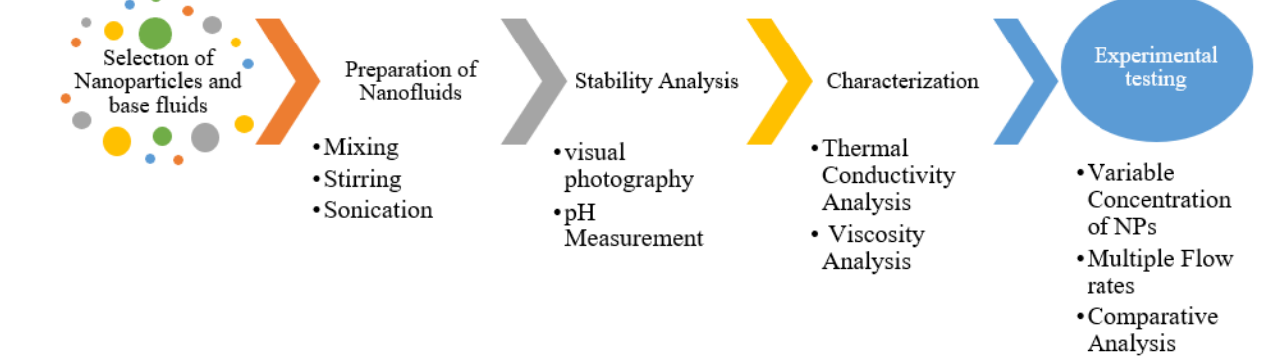
Figure 1. Research activity flow diagram.